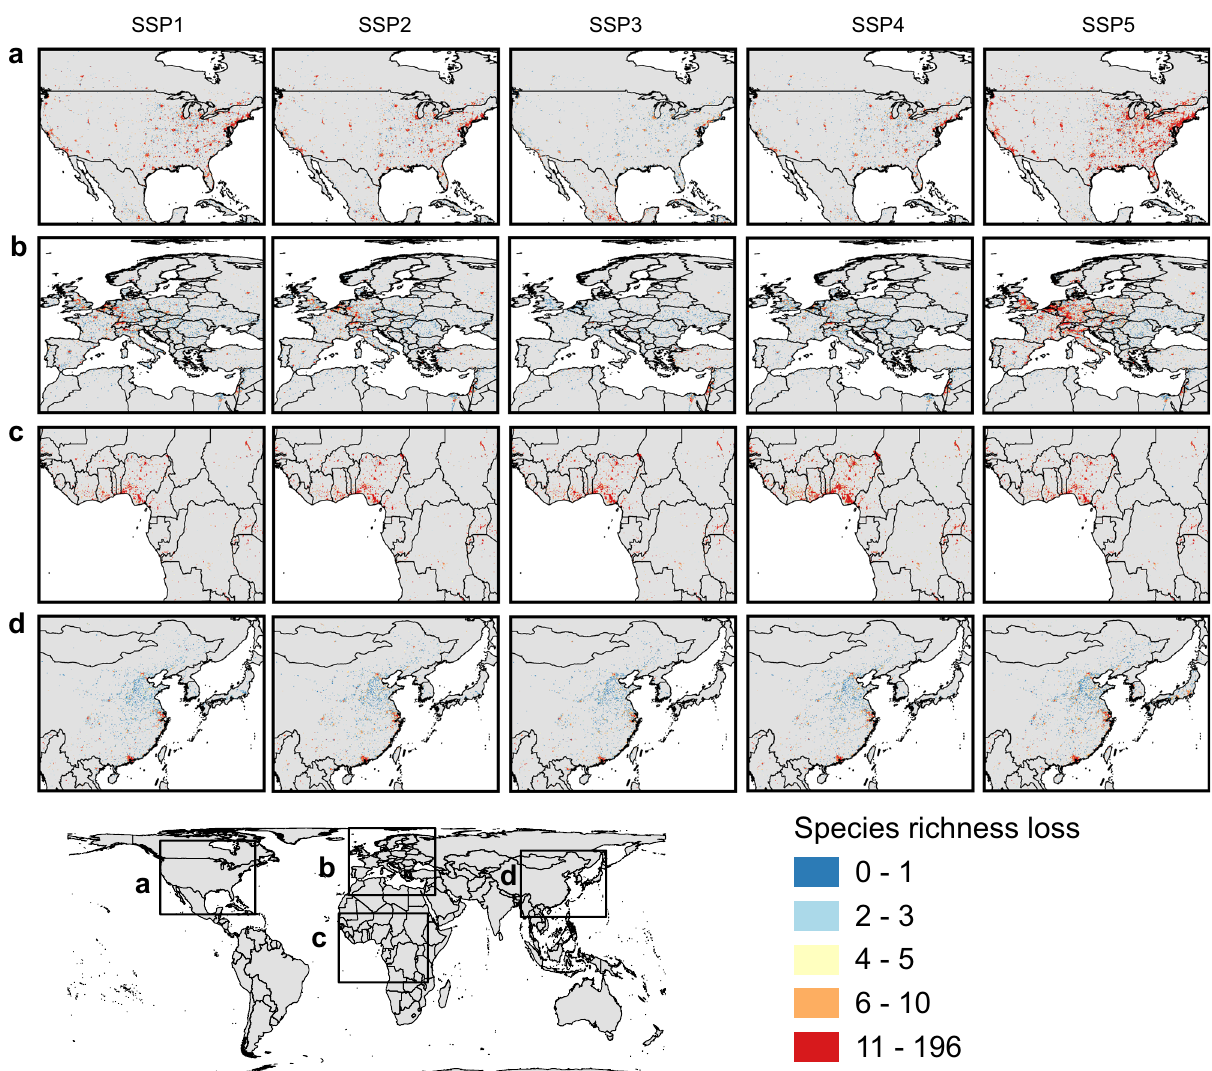
Fig. 4 Potential biodiversity loss due to future urban expansion under SSP scenarios. The biodiversity loss in terms of the number of terrestrial vertebrate species (amphibians, mammals, and birds) lost per 10 km grid cell in the North America ( a ), Europe ( b ), the Gulf of Guinea coast ( c ), and East Asia ( d